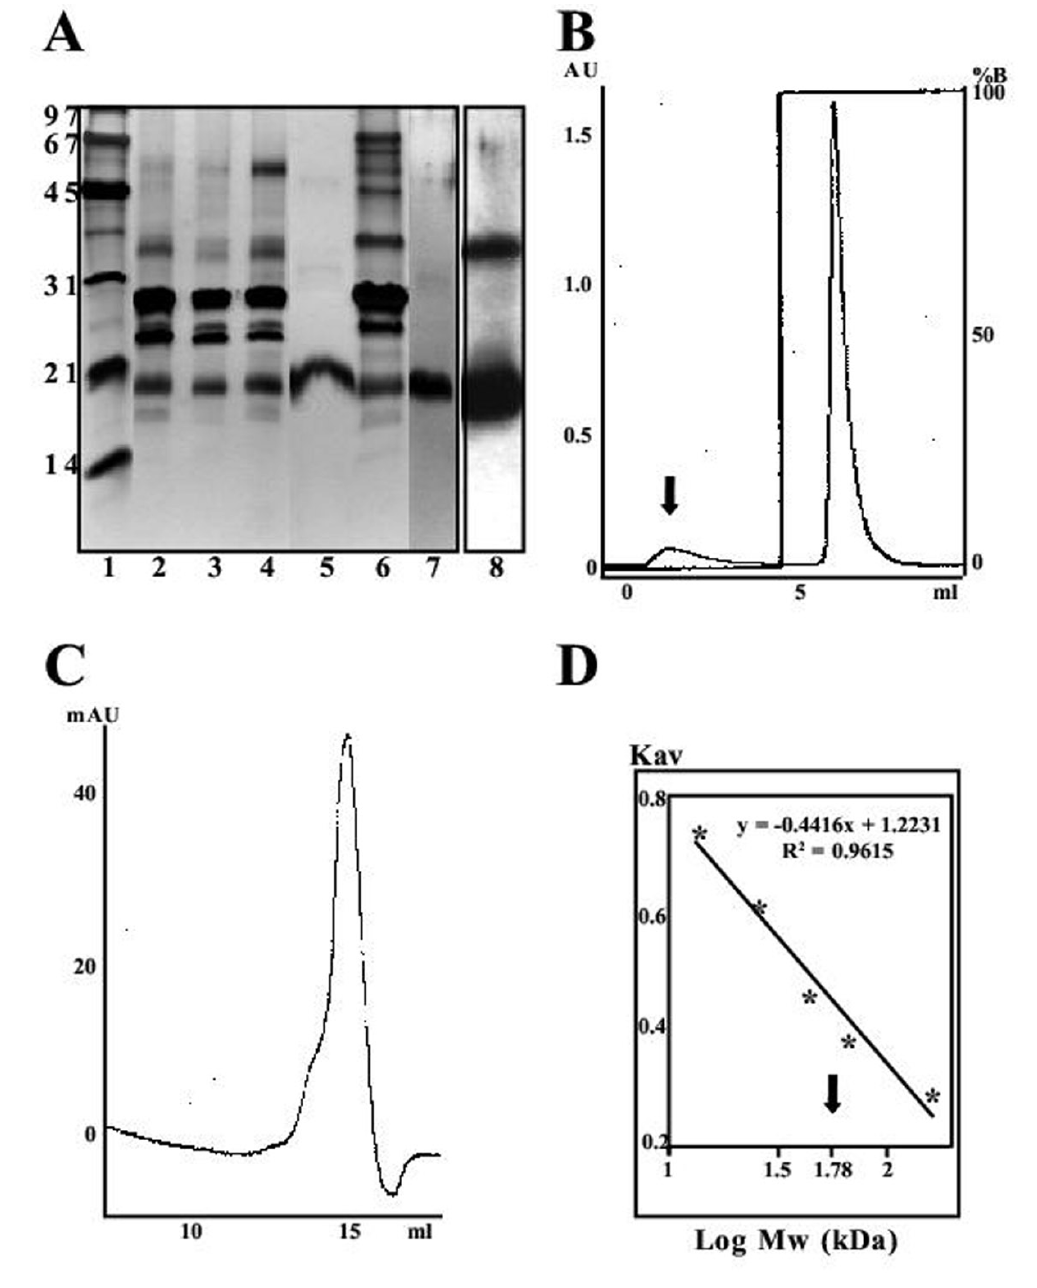
Figure 2 Purification and characterization of lens MP20. (A) SDS-PAGE and Western blot documentation of the purification process. Lane 1: Molecular weight markers. Lane 2: Fully stripped membranes showing significant enrichment in MP20 (20 kDa), and other integral membrane proteins including MIP (26 kDa) and its 22 kDa cleavage product, and MP38 which is the cleavage form of connexins 46 and 50. Lane 3 and 4: Insoluble and soluble fractions, respectively, following treatment of membranes with DM. Lane 5 and 6: Soluble proteins that did not bind (mostly MP20) and proteins that did bind to the MonoQ, respec- tively. Lane 7: Pure MP20 eluted from size exclusion chromatography column S-200. Lane 8: Immunoblot of lane 5 identifying MP20 and its dimer that is not detected in the stained gel. (B) Single step purification of MP20 on a MonoQ column. MP20 is the only major integral membrane protein that does not bind to the column at pH 8 (arrow). (C) Size exclusion chromatogra- phy of pure MP20. The protein was eluted at 15 ml. AU and mAU are absorbance units at 280 nm. (D) Calibration of the S-200 column. Vo = 8 ml. MP20 has an apparent molecular mass of 60 kDa